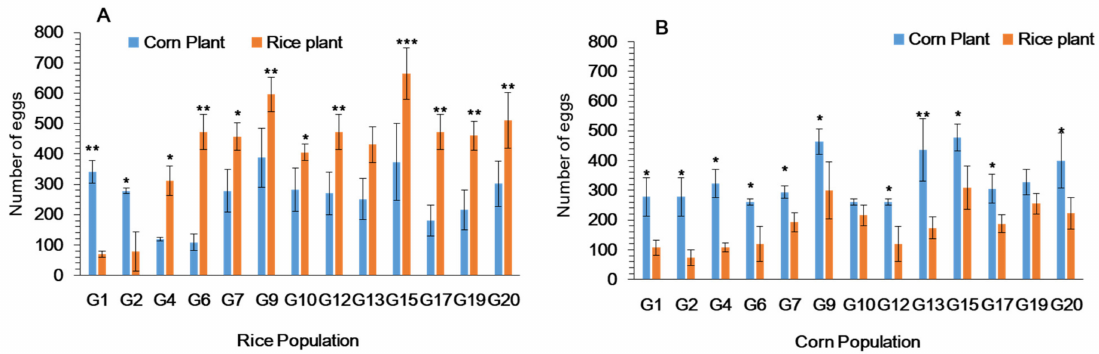
Figure 5. Total number of eggs laid by Spodoptera frugiperda adults on rice and corn plant when larvae reared on ( A ) rice and ( B ) corn plants for 20 generations. Data are means ± SE. Asterisks *, ** and *** show significant differences between host plants ( p < 0.05) based on post hoc Tukey’s HSD test.